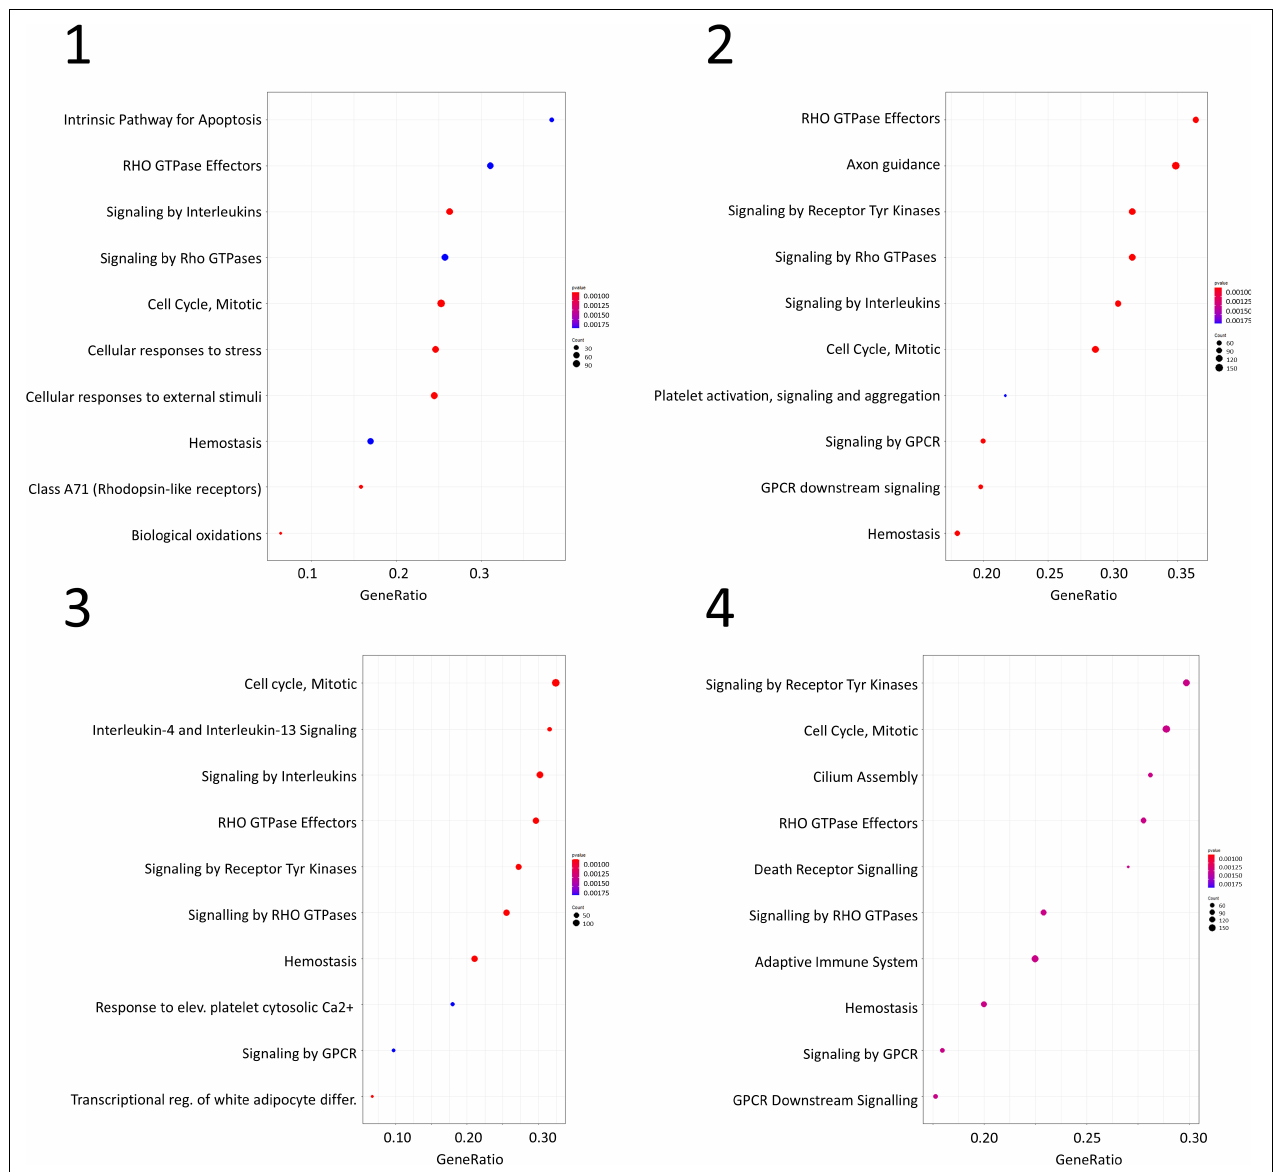
FIGURE 3 | Dot plots for the four GSEA results. Numbers refer to patients as indicated in Table 1 . Dot size is proportional to the number of overlapping genes. p -values are color-coded according to the color